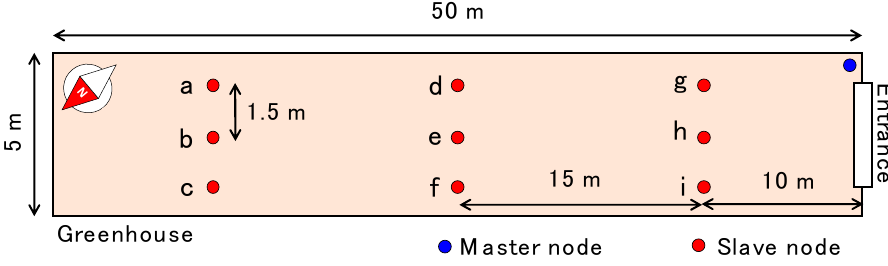
Figure 5. Dimensions of the greenhouse and locations of the master and slave nodes.